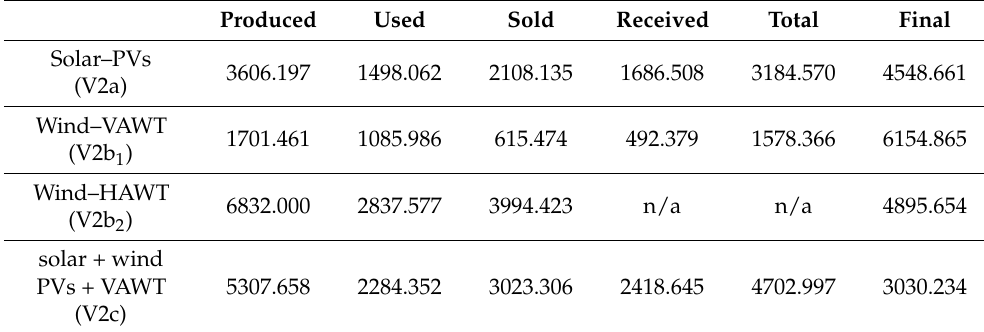
Table 5. Application of RES (in MWh/a) in the Nowosolna cluster—summary. Produced Used Sold Received Total Final